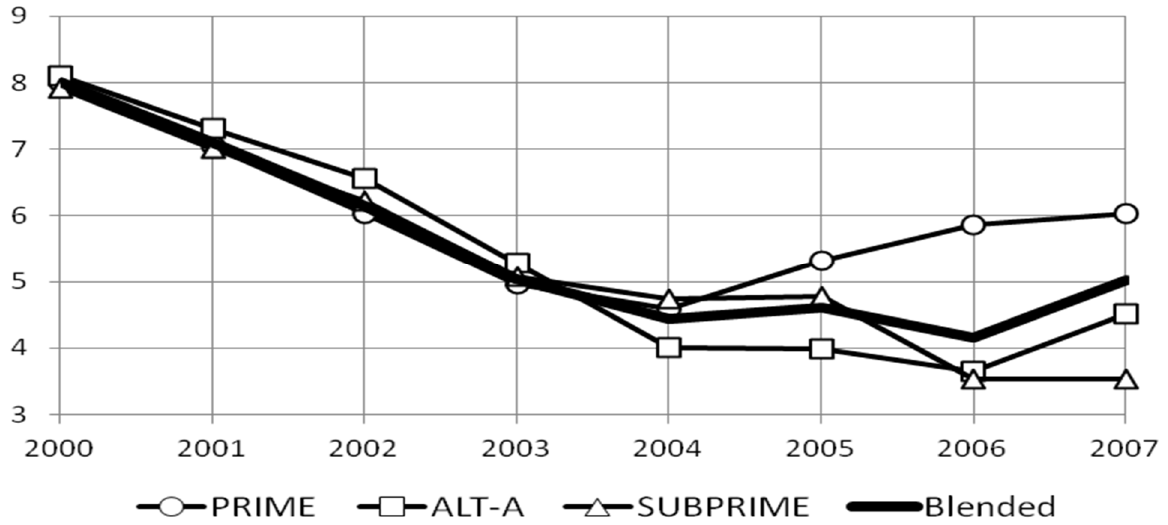
Figure 3. Loss Adjusted Coupon Rate. Source: Davidson Company Inc.